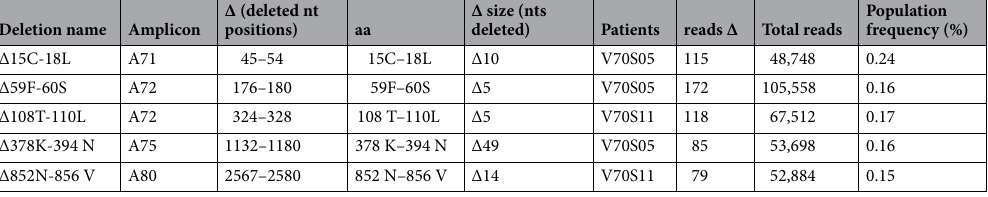
Table 4. Variant B.1.1.7